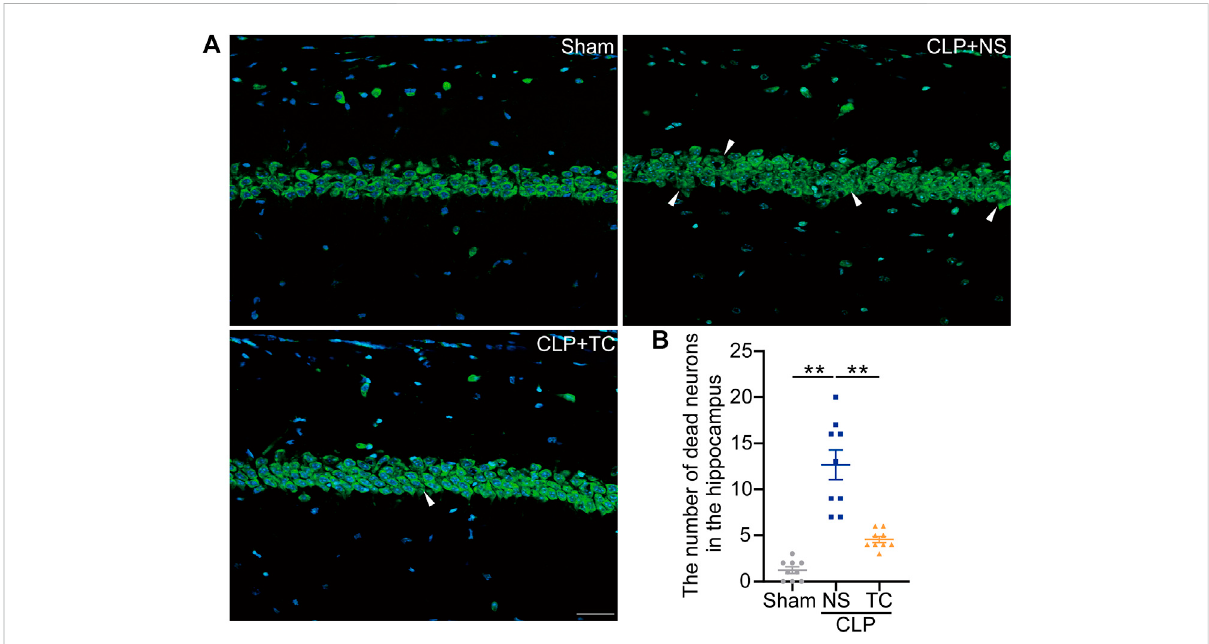
FIGURE 8 Neuronal loss in the hippocampus was reduced in the TAT-CIRP-treated septic mice. ( A) . NeuroTrace ™ Nissl staining in the hippocampus at 14 daysafterCLP(bar=30 μ m). (B) .Thenumberofdeadneuronsinthehippocampusamongdifferentgroups.* p < 0.05,** p < 0.01.Dataareshown as the mean ± SEM ( n =